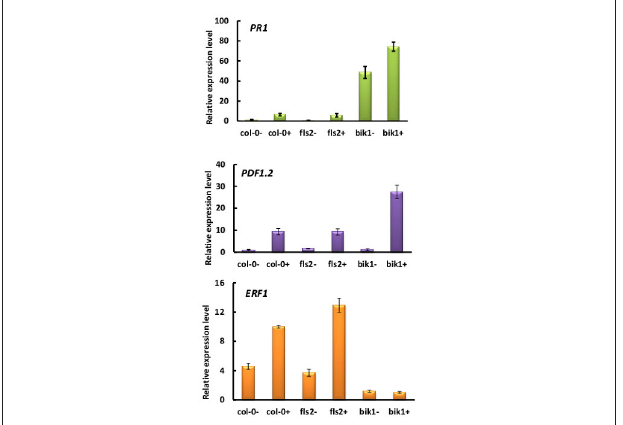
FIGURE 6 | Relative expression of SA, JA, and ET marker genes PR1 , ERF1, and PDF1.2 in response to infection with P. brassicae for 21 days ( − = uninfection, + = infection). P. brassicae infection up-regulated the expression of these genes in both wild-type and mutant plants.